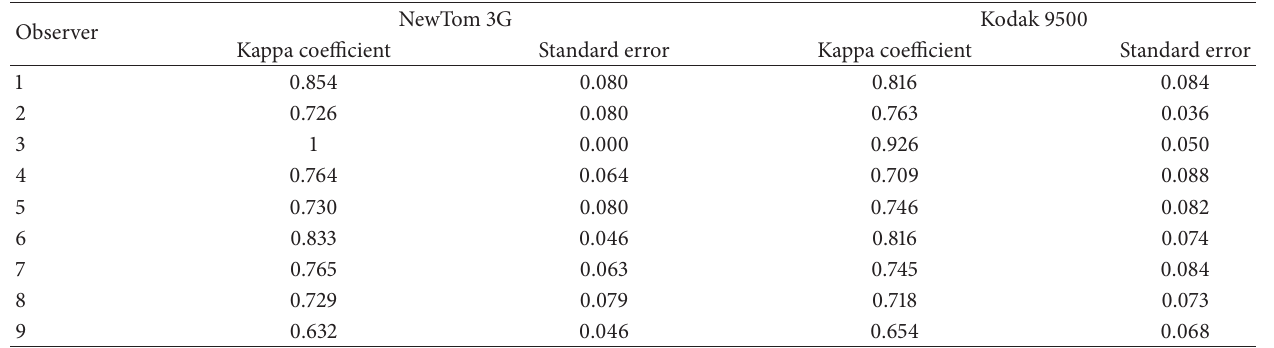
Table 4: Kappa coefficients for intrarater agreement between 𝑡 2 and 𝑡 3 , clustered by scanner type.